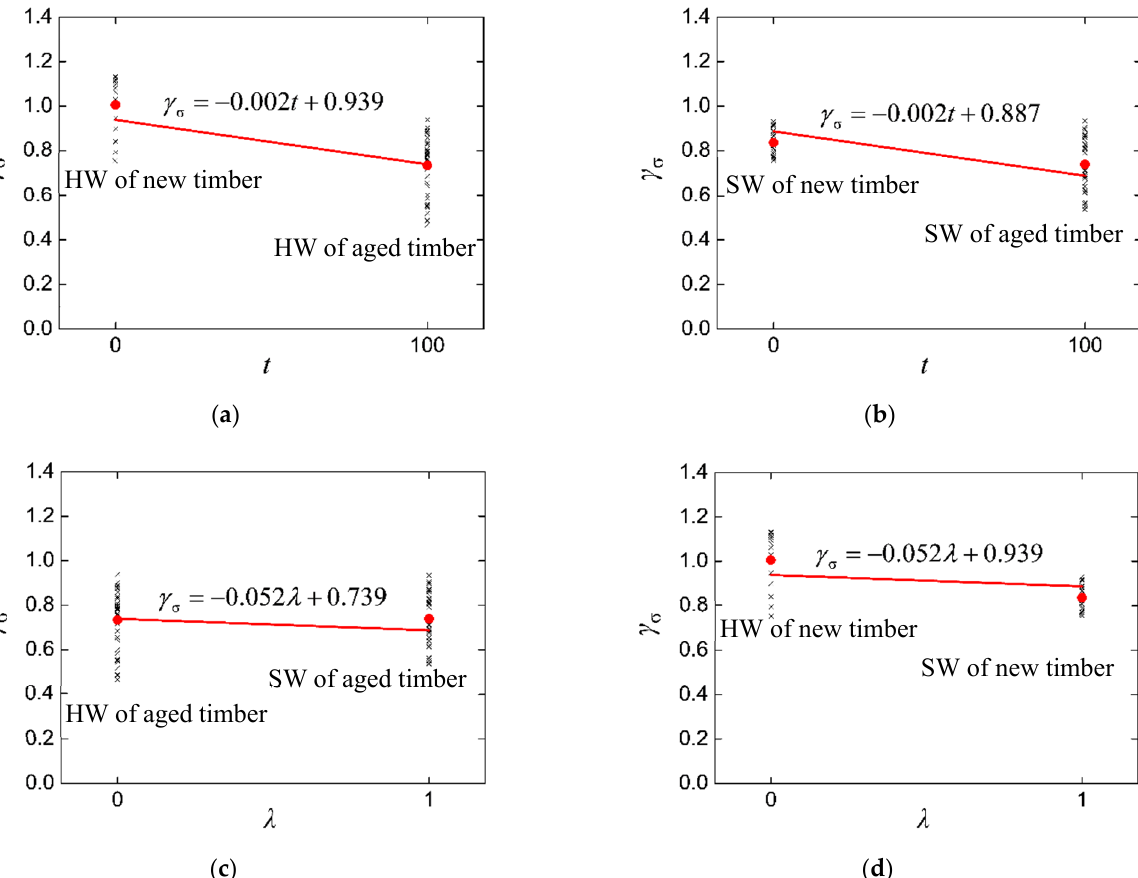
Figure 7. Outer contour lines of the plane: ( a ) λ = 0, ( b ) λ = 1, ( c ) t = 100, and ( d ) t = 0. The fitted distribution can be used to estimate the parallel-to-grain compressive strength of the log samples in this study. The estimated results using Equations (5) and (6) are listed in Table 5. The average difference between the estimated and experimental compressive strengths of the HW and SW were 12.70 and 11.40%, respectively, and this was considered satisfactory given the large variability in the properties of the aged CL [34]. Table 5. Estimation of compressive strength of the log samples using Equation (6).